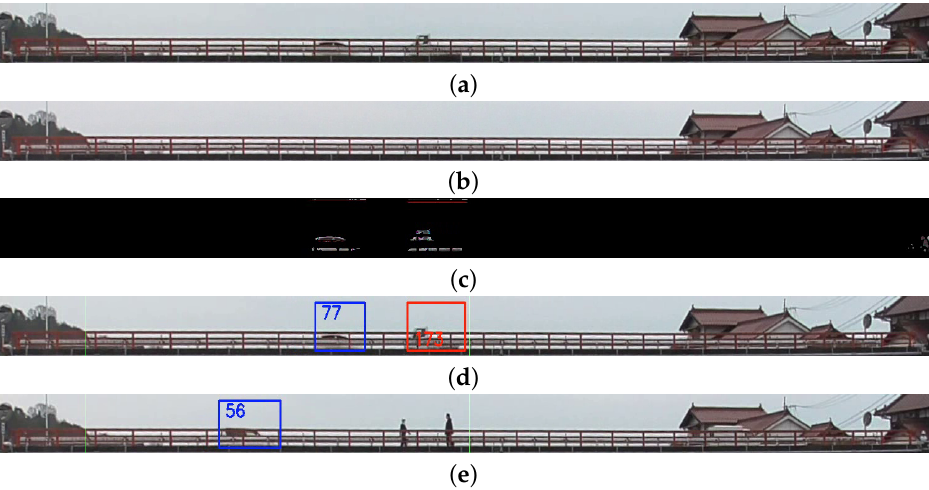
Figure 7. Captured frames from the video stream of traffic counting camera, cropped within the region of interest covering the bridge’s deck ( a ). The background image for the image segmentation process is captured when no vehicle is present on top of the bridge, updated with a 10-min interval ( b ). Detected vehicle blob after background subtraction ( c ), the current background image is subtracted from each frame to isolate only the moving objects. Detection frame with a unique ID assigned to the detected vehicles’ blob ( d ). The blob selection was able to filter out nonvehicular objects such as a walking pedestrian from vehicle detection based on minimum blob width ( e